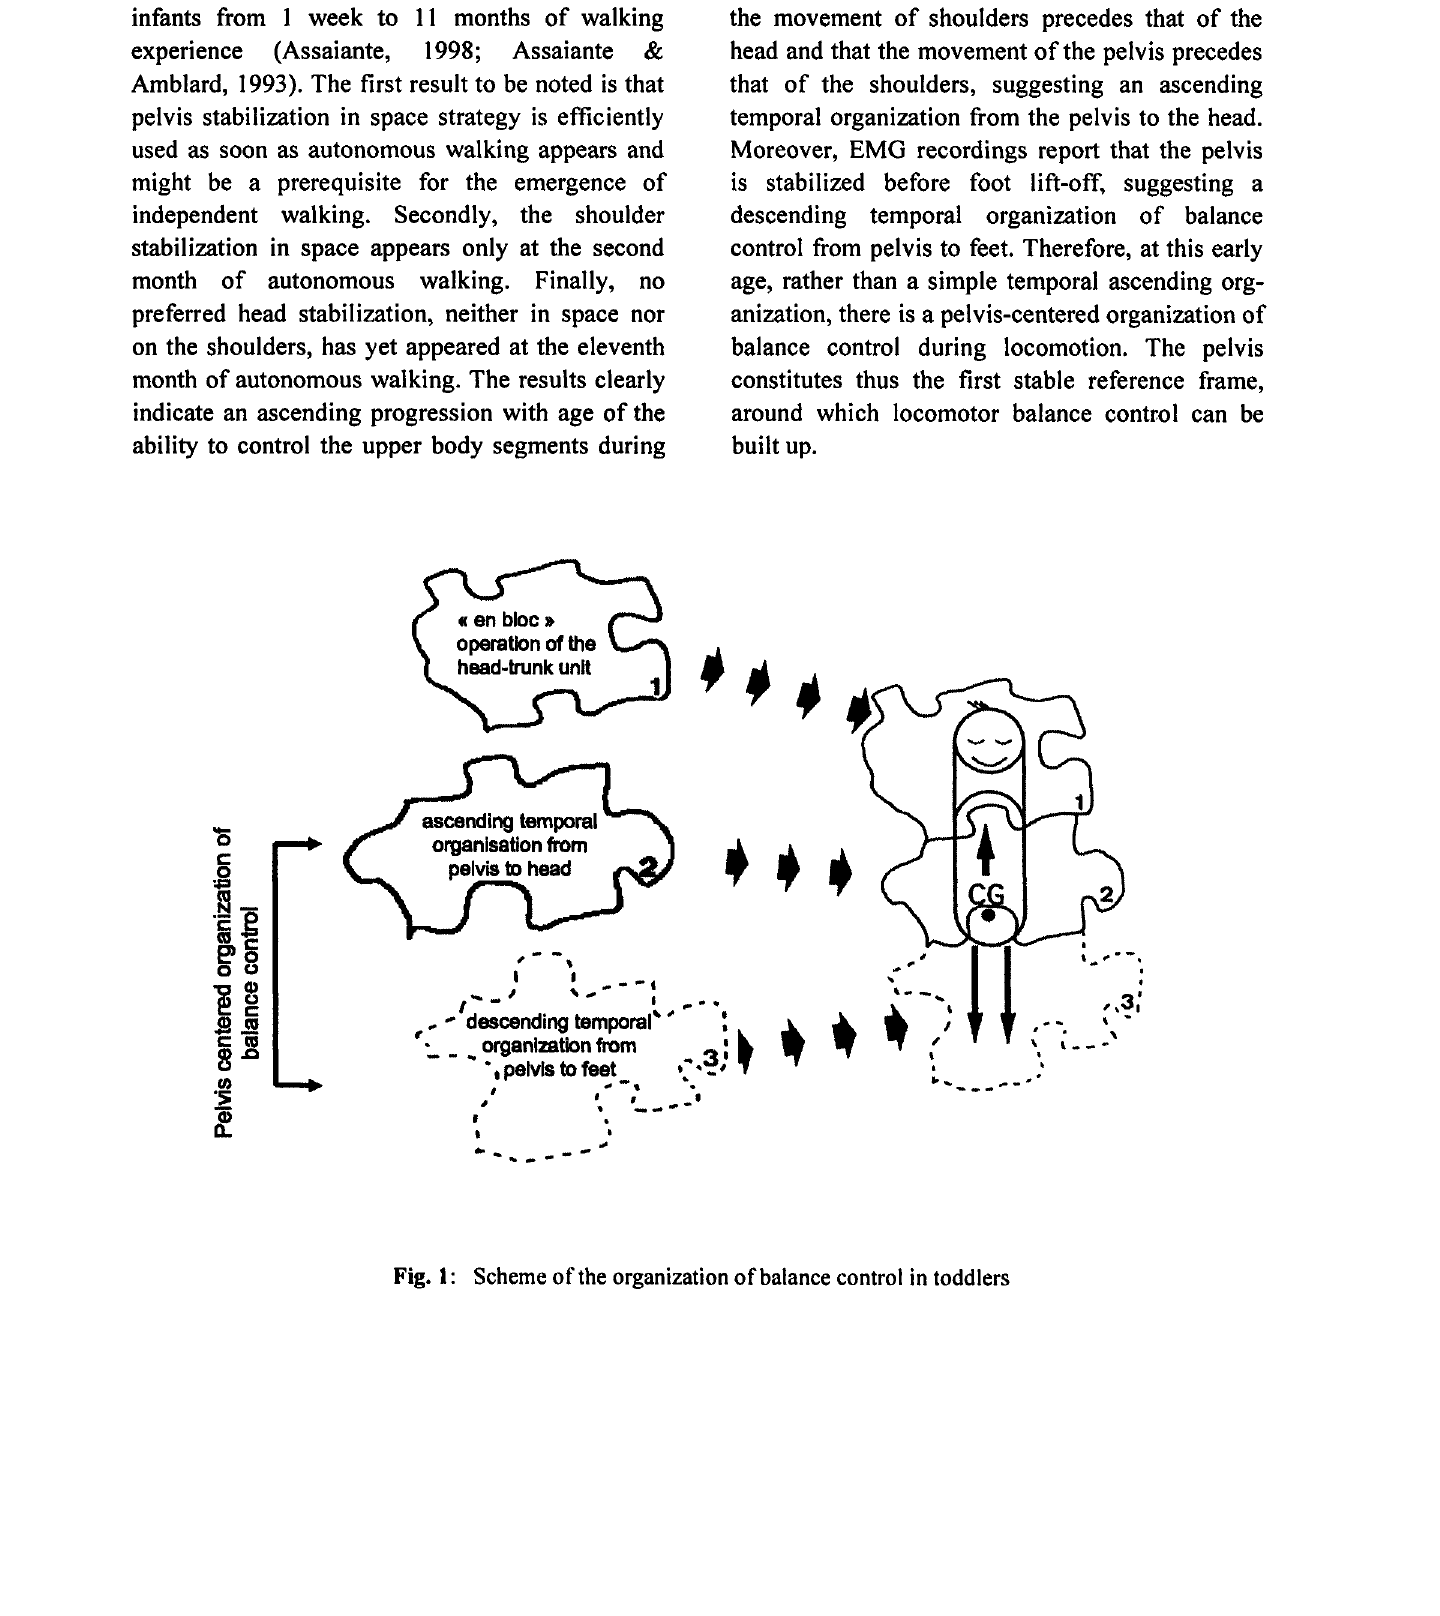
Fig. I" Scheme of the organization of balance control in